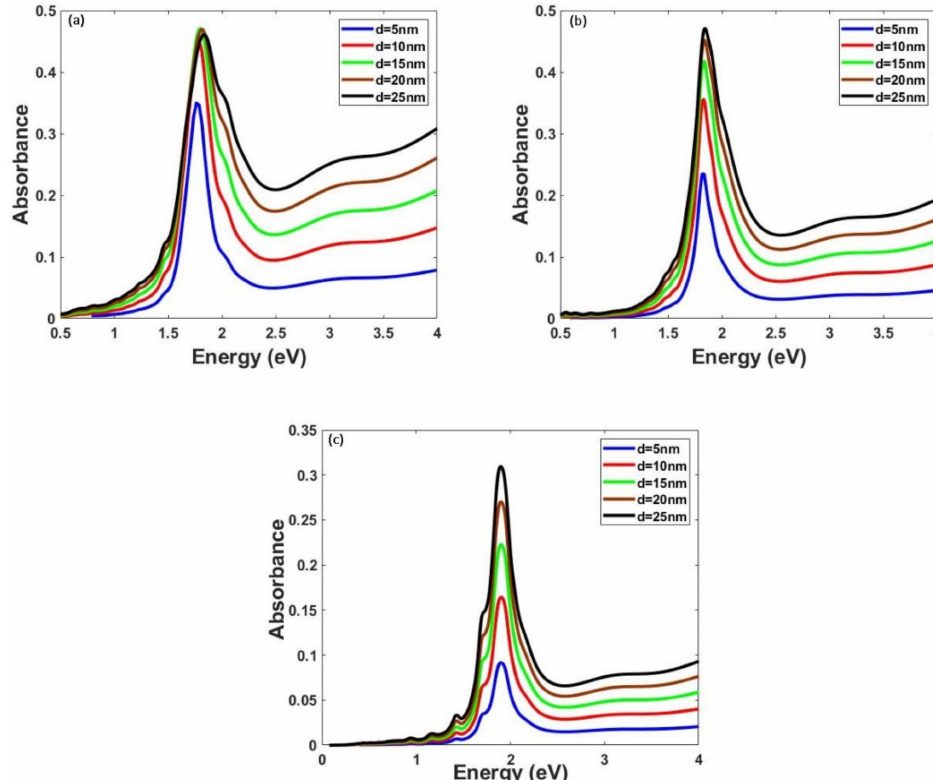
Figure 4. Size dependent LSPRs for d = 5 nm–25 nm and ( a ) a = (3/2) d ; ( b ) a = 2 d ; ( c ) a = 3 d .